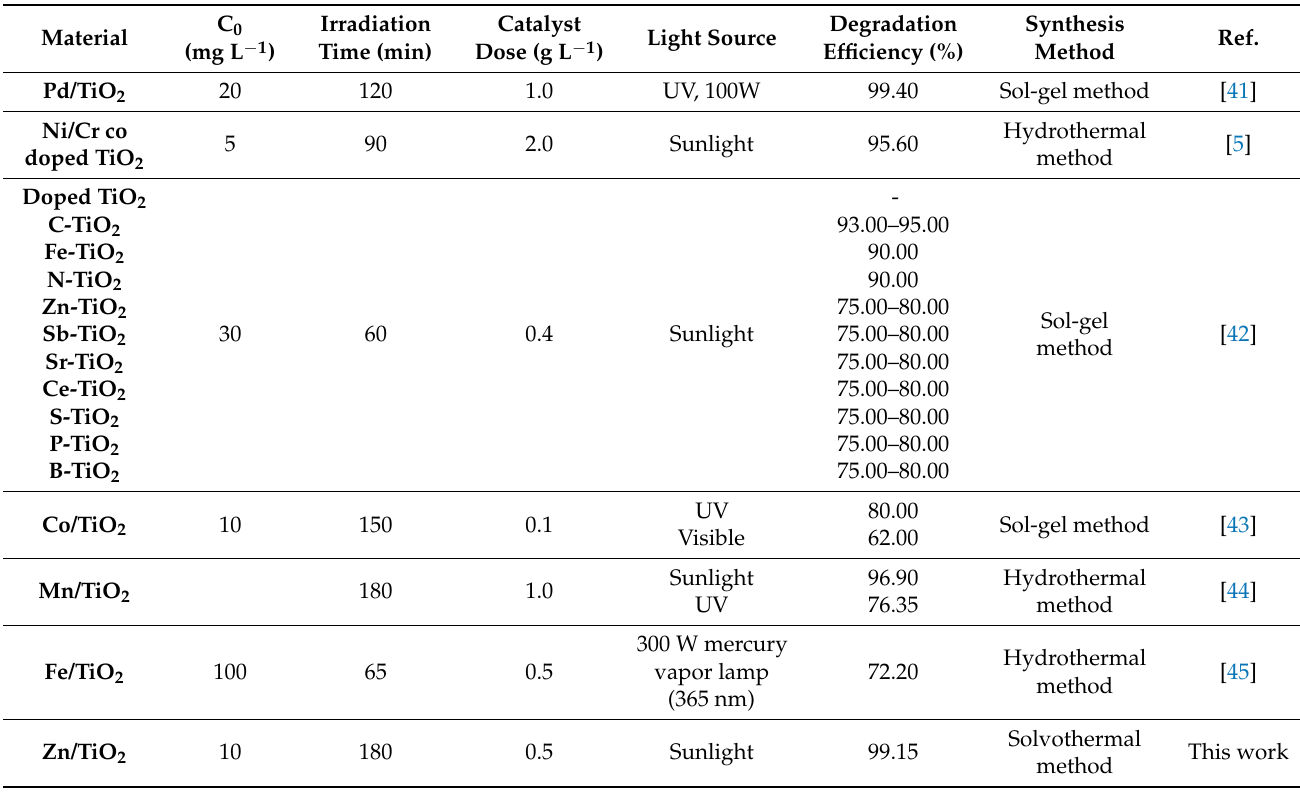
Table 4. A comparison of photocatalytic degradation of MB by different doped/codoped TiO 2 nanomaterials. Material